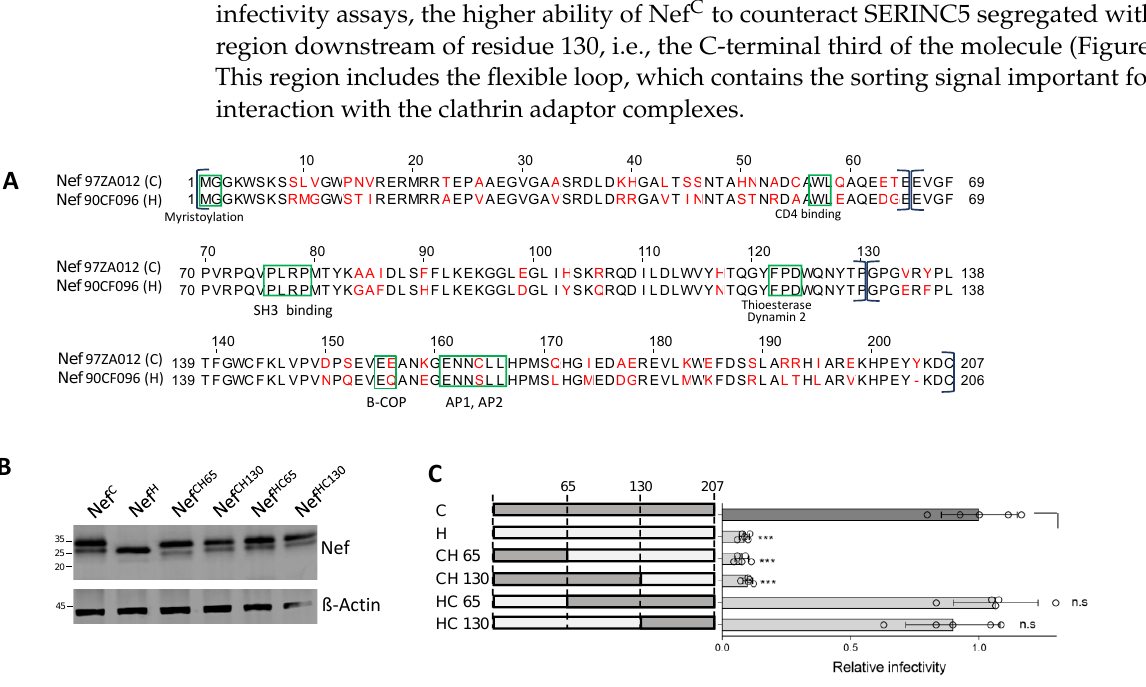
Figure 2. The defective SERINC5 counteracting activity of Nef H maps in the C-terminus third of the molecule. ( A ): Pairwise alignment of Nef H and Nef C showing the divergent residues (in red), some notable functional motifs (green rectangles), and the portions of the molecules swapped for the generation of chimeric proteins (brackets). ( B ): The indicated HA-tagged chimeric Nef proteins are detected by western blot in the lysates of virus producing cells. ( C ): Infectivity of HIV-1 limited to a single cycle of replication produced in the presence of SERINC5 and the indicated Nef proteins. Bar graphs represent the mean infectivity relative to the infectivity of the virus produced with Nef C . Mean ± s.d. (Biological quadruplicates), unpaired two-tailed t -test, *** p < 0.001,